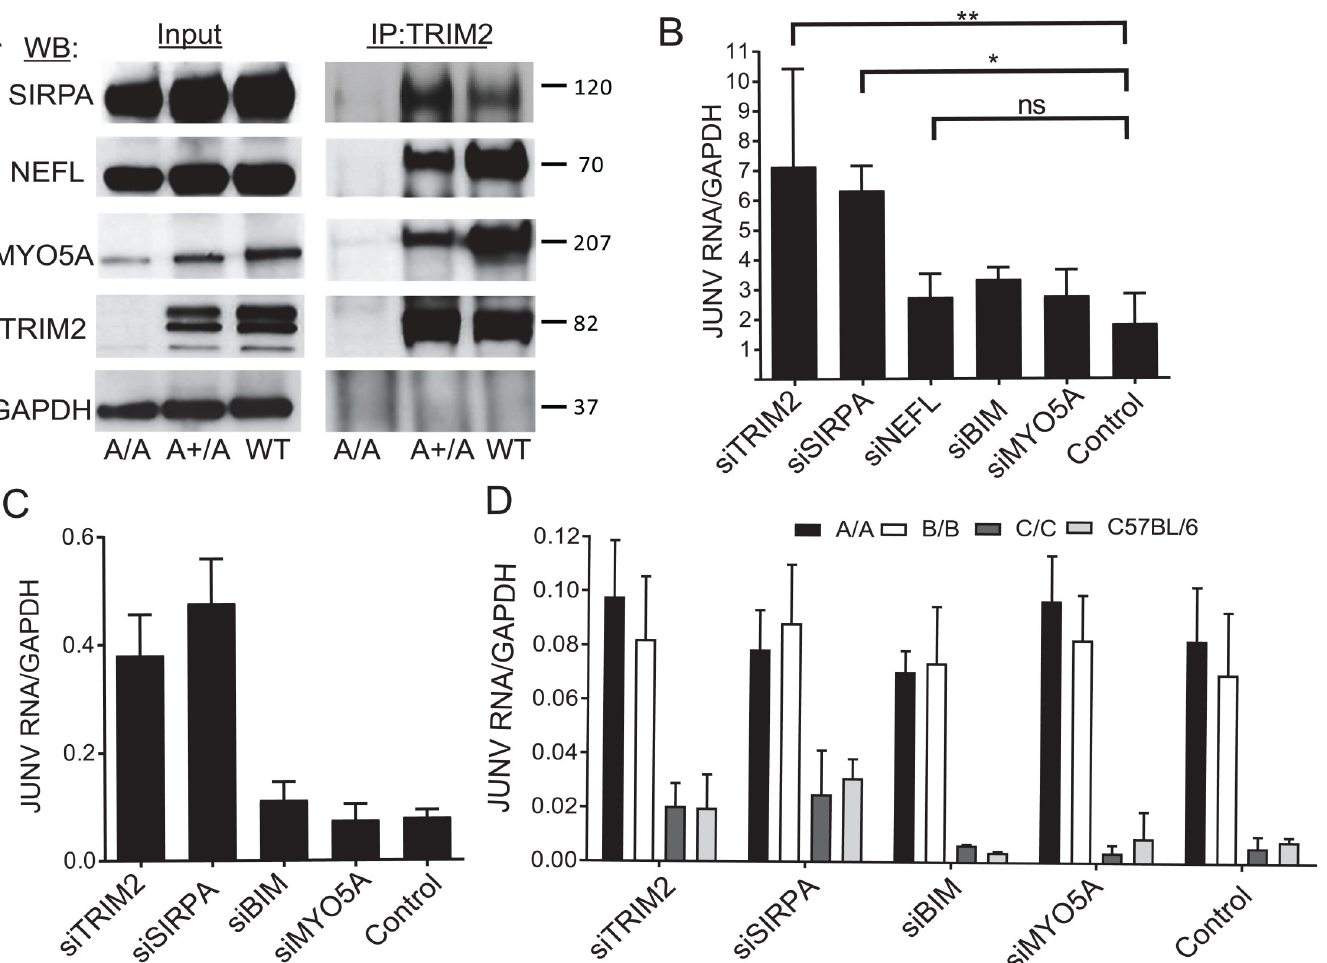
Fig 6. The TRIM2-interacting protein SIRPA also restricts New World arenaviruses. (A) Co-IP of TRIM2-interacting proteins. Brain extracts from strain A knockout, heterozygous, and C57BL/6 (WT) mice were immunoprecipitated with anti-TRIM2 antibody, and WBs were subjected to probing with anti-SIRPA, anti-NEFL, and anti- MYO5A antibodies; anti-GAPDH antibodies served as a control. (B) U2OS and (C) THP-1 cells were transfected with the indicated siRNAs and infected with Candid 1, and RNA was isolated 24 hpi and analyzed for viral RNA. Values in B represent the average of 3–4 independent experiment ± SD. Statistical significance was calculated by one-way ANOVA. � P � 0.01; �� P � 0.002. Values in C represent the mean ± SD in 2 independent experiments with triplicate experimental replicates. Knockdowns of the genes in U2OS and THP-1 cells are shown in S5A and S5B Fig, respectively. (D) Primary bone marrow–derived macrophages from mice of the indicated genotype were transfected with the indicated siRNAs. Values represent the average ± SD in 2–3 independent experiments with triplicate experimental replicates. Knockdown of the genes is shown in 5SC Fig. BIM, Bcl-interacting mediator of cell death; GAPDH, glyceraldehyde-3-phosphate dehydrogenase; hpi, hours post infection;